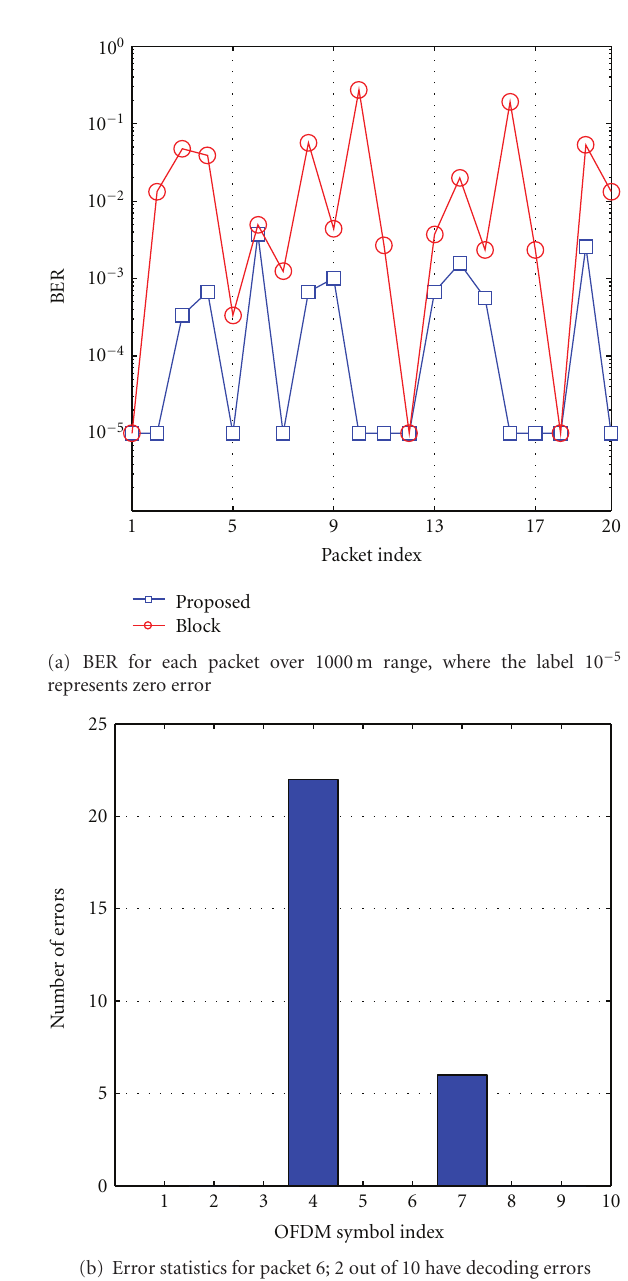
(b) Error statistics for packet 6; 2 out of 10 have decoding errors Figure 8: Performance of the proposed system at 1024